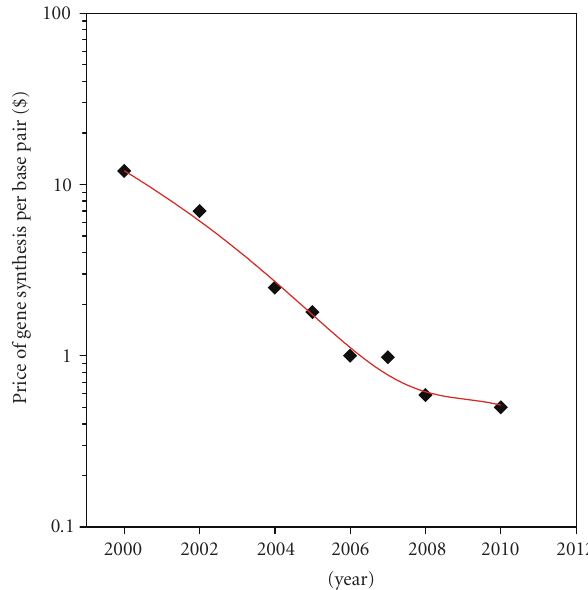
Figure 1: The decrease of large-scale de novo DNA synthesis